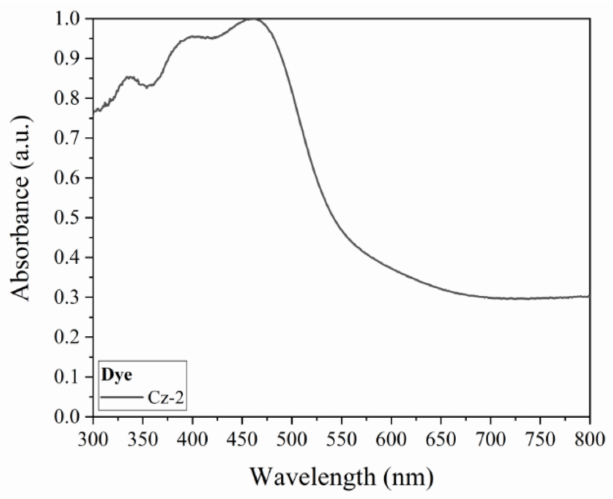
Figure 5. Diffuse reflectance spectroscopy (DRS) curve of the working electrode that was sensitized by the Cz-2